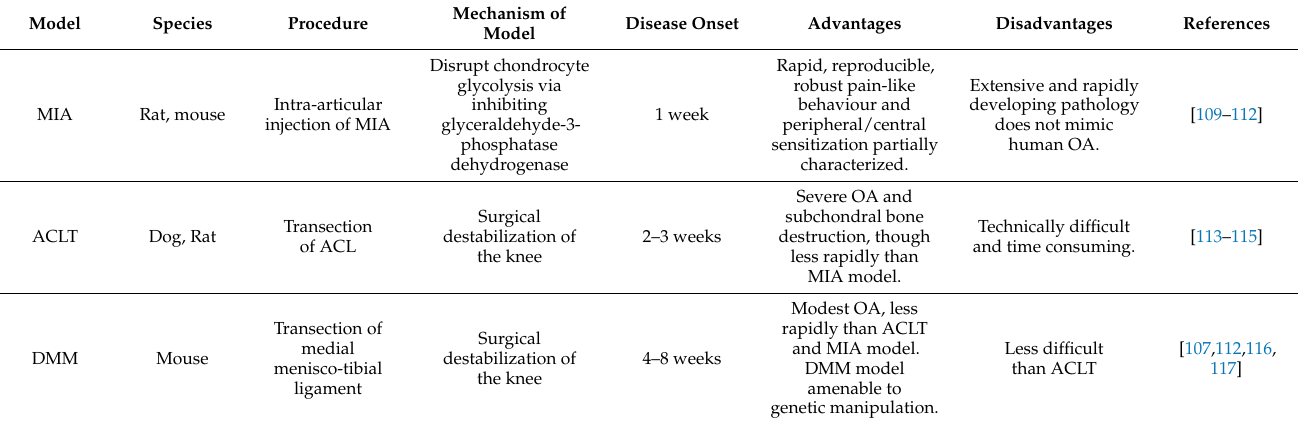
Table 1. Comparison of the most commonly used animal models for OA